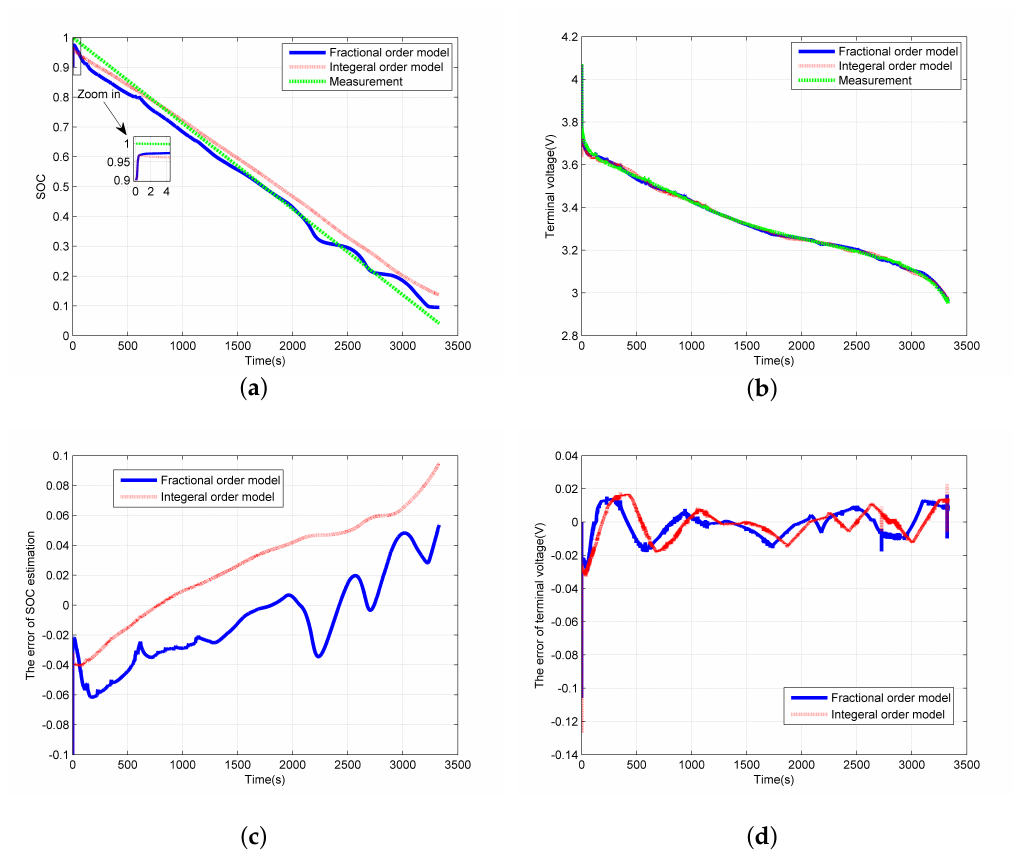
Figure 7. The results of static discharge experiment. ( a ) The results of SOC estimation; ( b ) The results of battery terminal voltage estimation; ( c ) The errors of SOC estimation; ( d ) The errors of battery terminal voltage